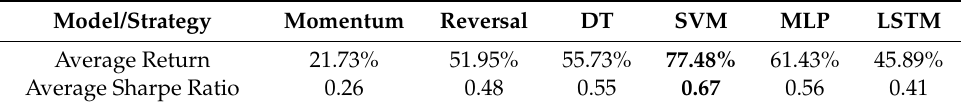
Table 10. Average measures for the models and